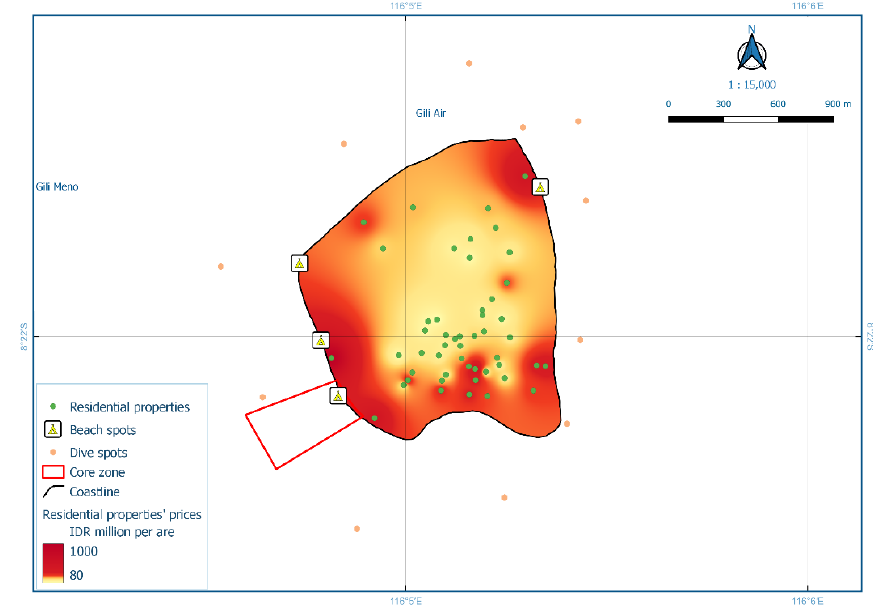
Figure 7. Interpolation of residential property prices for Gili Air Island (Model HR3).